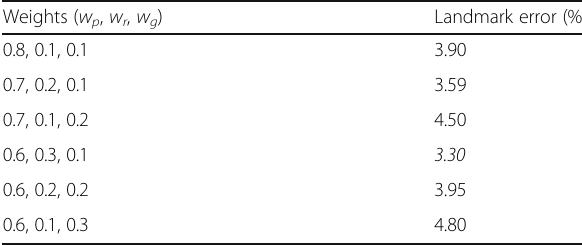
Table 1 Comparisons with different weights for pixel, region, and gradient differences Weights ( w p , w r , w g ) Landmark error